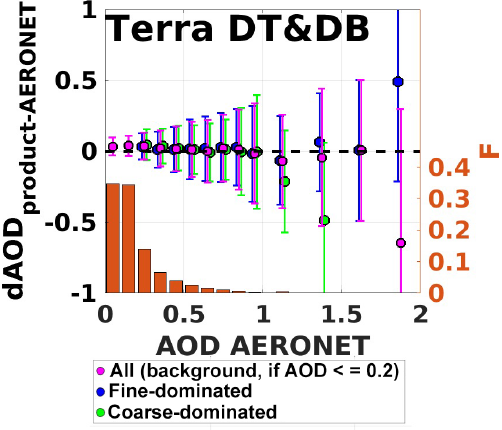
Figure 2. Difference between Terra DT&DB and AERONET monthly AOD for selected AOD bins: median bias (circles), bias standard deviation (error bars) for all AOD types (purple), back- ground aerosol (purple; AOD ≤ 0 . 2), fine-dominated AOD (blue) and coarse-dominated AOD (green) The fraction (F) of points in each bin is represented by orange bars. For all individual products see Fig.